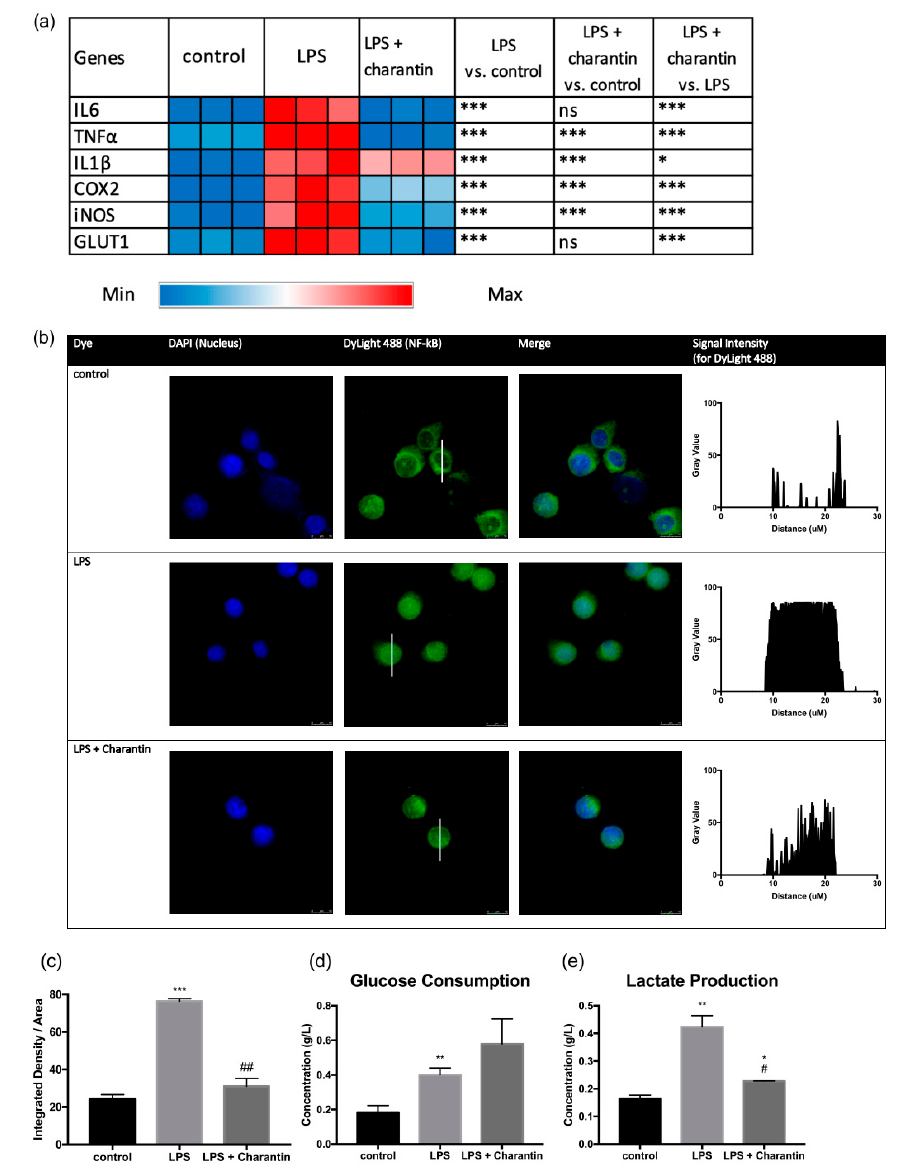
Figure 6. Bioactivities of charantin. ( a ) Charantin downregulated the expression of genes including IL6 , TNF- α , IL1 β , COX2 , iNOS , and GLUT1 in LPS-activated macrophages. ( b ) Charantin suppressed NF- κ B translocation following LPS stimulation and ( c ) its corresponding integrated density/area plot. Effect of LPS and MC treatments on ( d ) glucose consumption and ( e ) lactate production. For ( a ), * p < 0.05, *** p < 0.001; ns, no significant difference between groups. For ( c − e ), data are presented as mean ± SEM. Group comparison was performed using the Student’s t -test. * p < 0.05, ** p < 0.01, *** p < 0.001 compared with the control group; # p < 0.05, ## p < 0.01 compared with the LPS